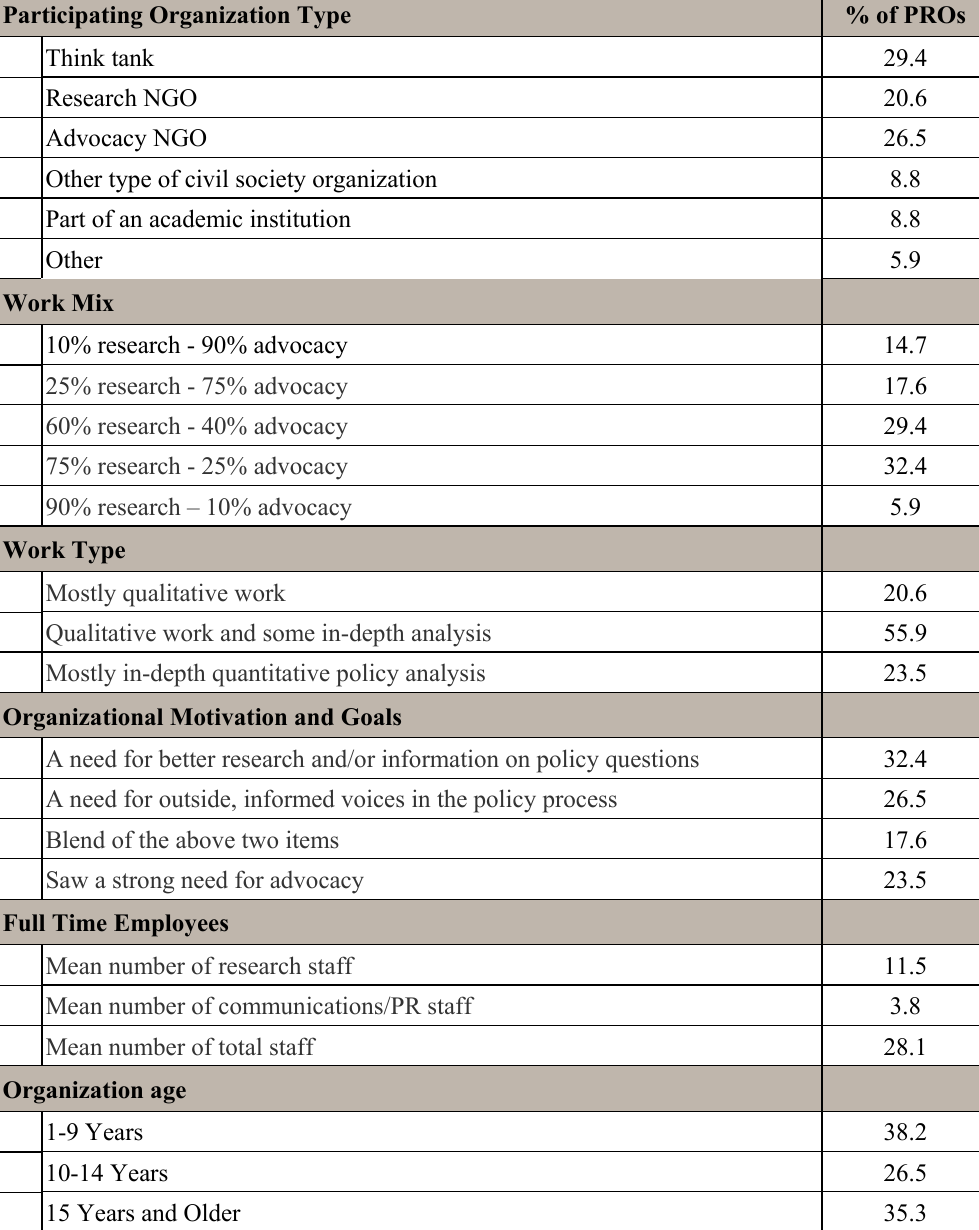
Table 1. General Characteristics of Included Organizations Participating Organization